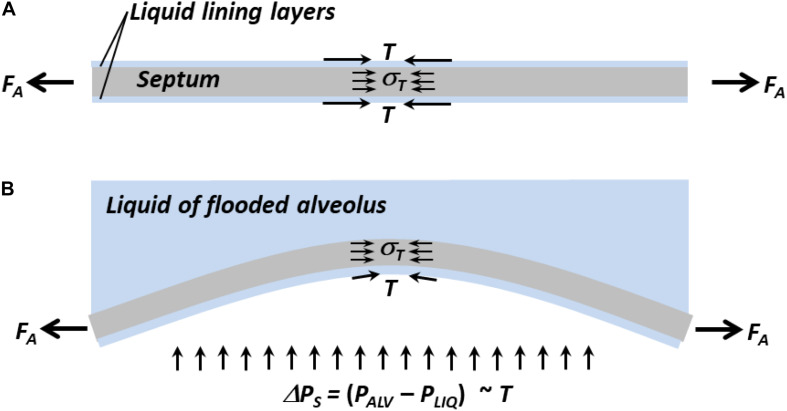
Forces acting on septa. (A) Normal planar septum between two aerated alveoli. Distending force FA applies axial tension. Interfacial surface tension, T, and tissue stress, σT, counter FA. (B) Intervening septum separating flooded (top) from aerated (bottom) alveolus. Due to ΔPS, which is ∼T, septum bows into flooded alveolus. Inflation-induced increases in FA and σT tend to reduce bowing. Inflation-induced increase in T acting along septum tends to reduce bowing, but inflation-induced increase in T also increases ΔPS, which tends to increase bowing. Net result is that inflation sometimes increases bowing (Figure 1A).